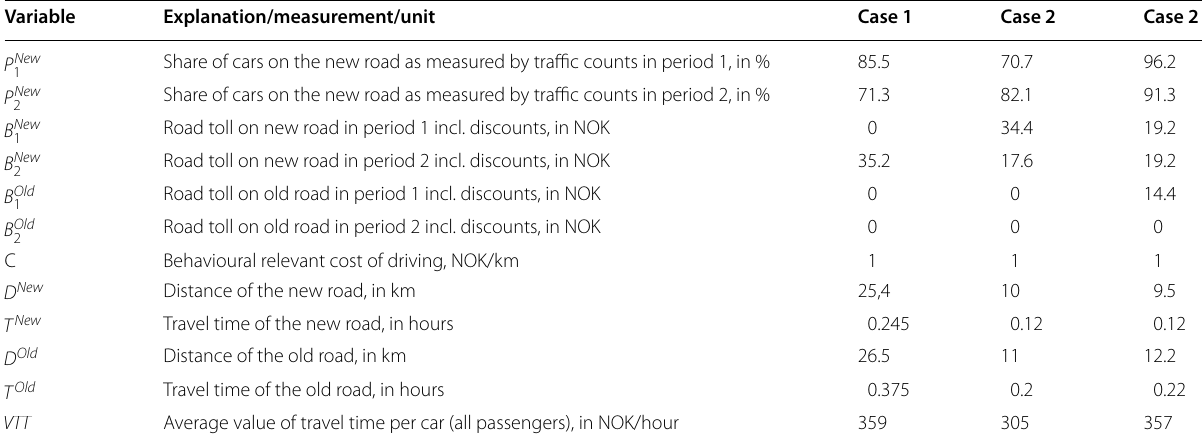
Table 3 Input data to our